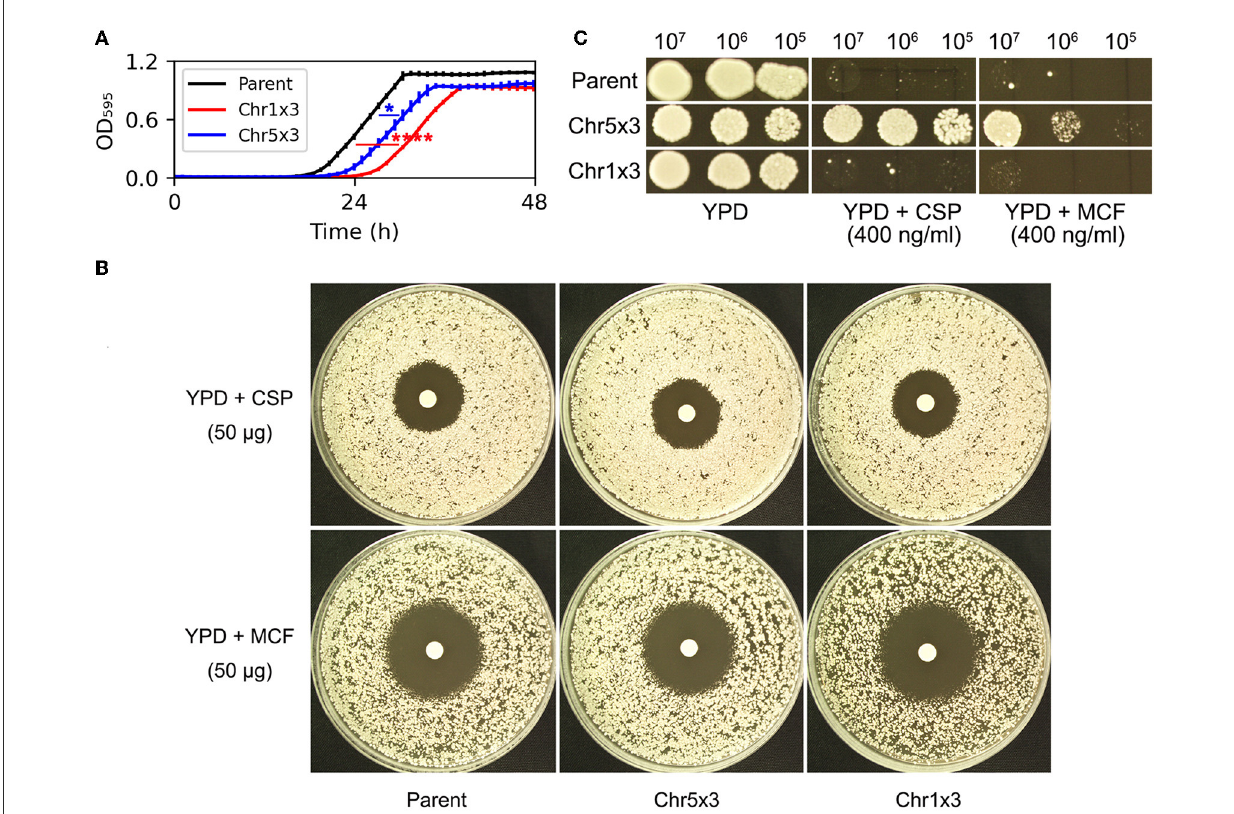
FIGURE2 Fitness loss and gain in caspofungin adaptors. The fitness cost of adaptation to caspofungin (CSP) was evaluated by growing strains in YPD broth without stress (A) . Optical density at 595nm (OD 595 ) was measured every 1h for 48h at 37 ◦ C using a Tecan plate reader (Infinite F200 PRO, Tecan, Switzerland). Data are represented as the mean ± SD of three biological repeats. * and **** indicate p -values < 0.05, and p < 0.0001, respectively, as determined by Tukey’s HSD test. In (B) , disk diffusion assays were performed to compare Chr1x3 and Chr5x3 adaptors to parent for resistance to CSP and micafungin (MCF). The paper disks contained 50 µ g of CSP or MCF as indicated in the figure. In (C) , 3 µ l of 10-fold serial dilutions were spotted on YPD plates. Drug concentrations are shown in the figure. In (B) and (C) , the plates were incubated at 37 ◦ C for 72h and then